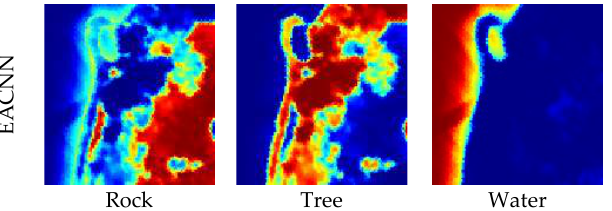
Figure 7. The abundance results of the Samson Dataset estimated using the proposed method.